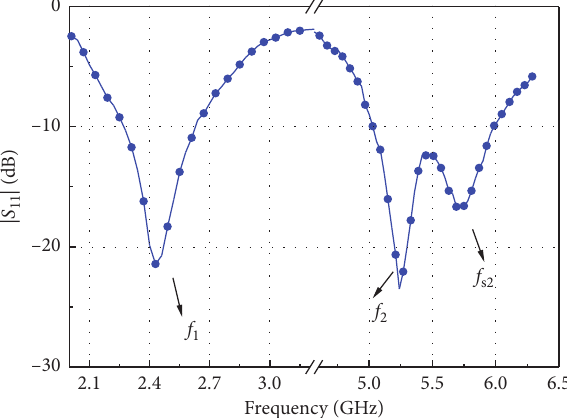
Figure 3: The simulated | S 11| for the proposed